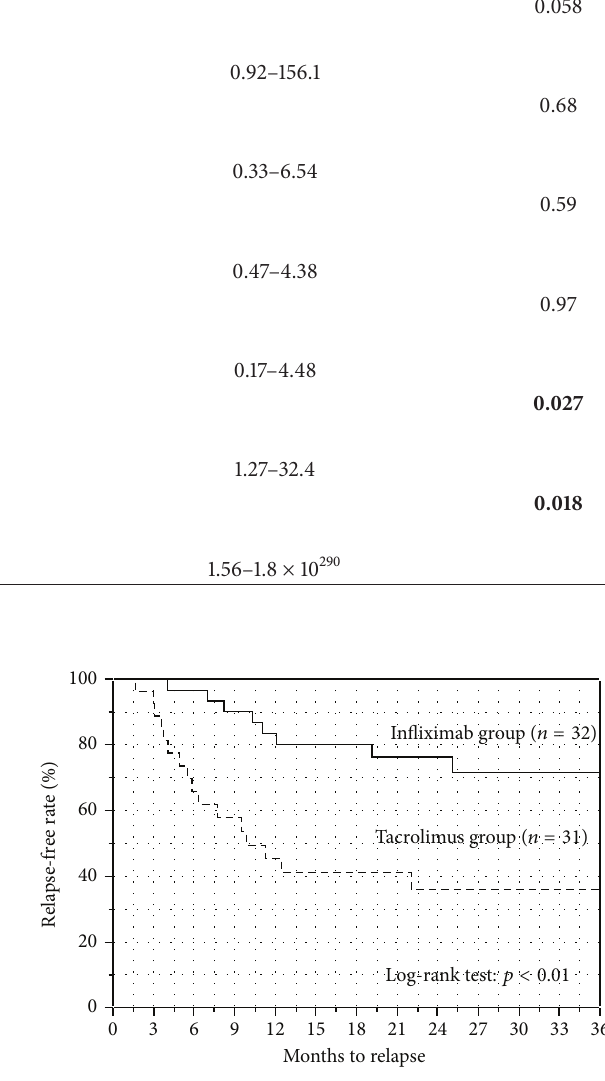
Figure 4: Kaplan-Meier plots for relapse-free survival. The relapse- free survival rate at 3, 6, 12, and 18 months was 100%, 97%, 83%, and 83% in the infliximab group (𝑛 = 32) and 90%, 57%, 37%, and 37% in the tacrolimus group (𝑛 = 36) , respectively. The relapse-free survival rate was significantly higher in the infliximab group than in the tacrolimus group ( 𝑝 < 0.001 ; log-rank test).